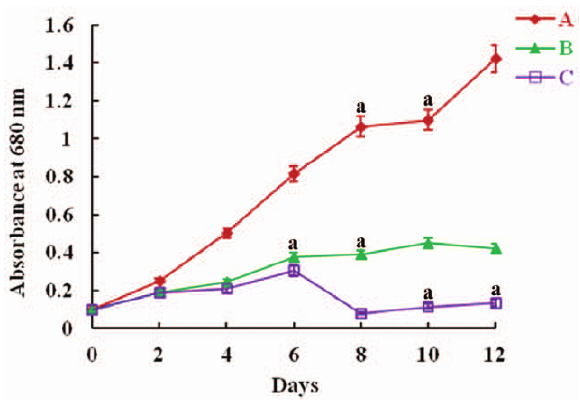
Figure 7. Growth of Synechocystis sp. strain PUPCCC 64 in basal medium (A) with 0.01 g K 2 HPO 4 L 2 1 , (B) with 2.5 mg anilofos L 2 1 without phosphate and (C) without phosphate. All presented data are the mean values of three independent experiments 6 SD Data at different time intervals with same lower case letters are not significantly different from each other at the 95% confidence level (p , 0.05).